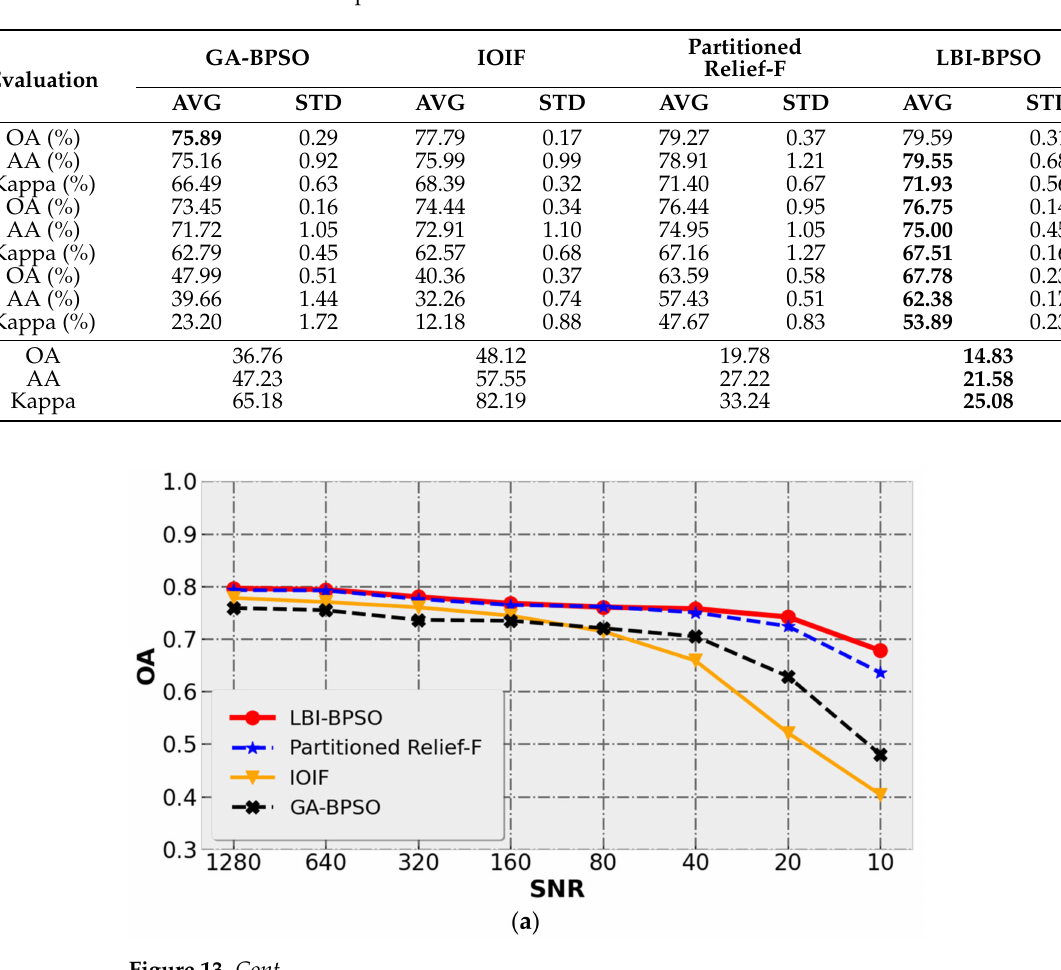
Table 4. Test results of partial SNR conditions.